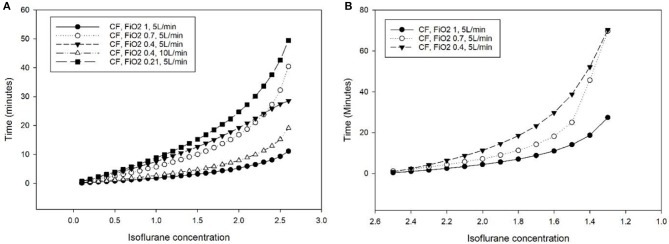
Additional time (minutes) required to reach a specific isoflurane concentration in the breathing system of the Tafonius anesthesia machine during mechanical ventilation of a lung model (bag in a bottle) with a computer-driven flowmeter (CF) at different settings, compared to the use of a manual flowmeter at 5 L minute−1. (A) Isoflurane increase from 0 to 3% (dial setting of a calibrated TEC 3 vaporizer). (B) Isoflurane decrease from 2.7 to 1%.